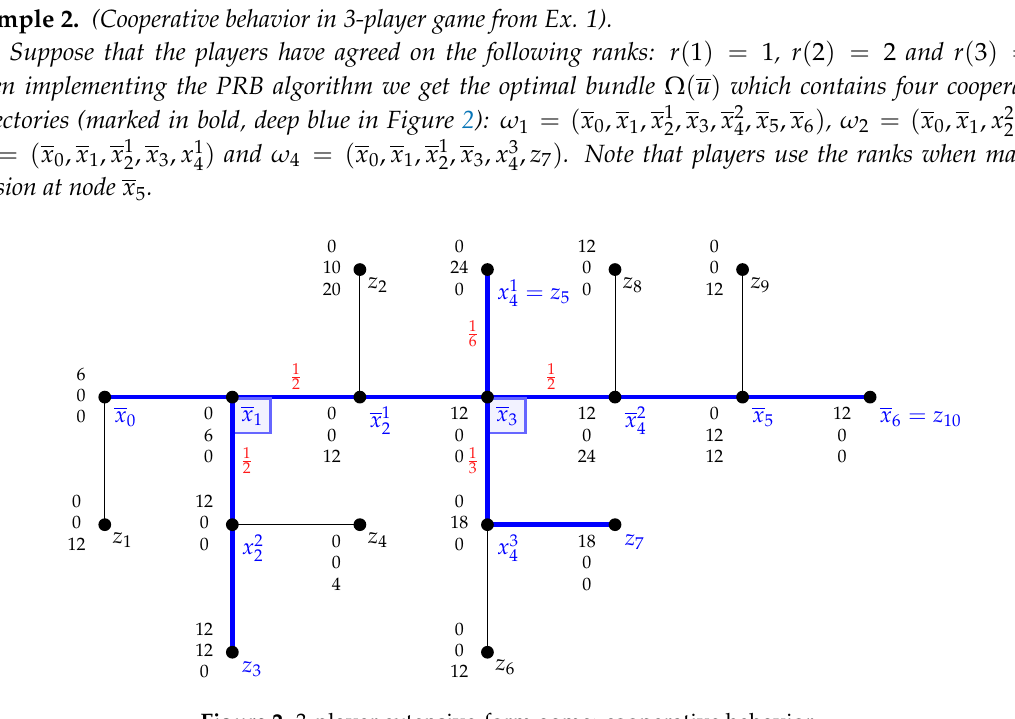
Figure 2. 3-player extensive-form game: cooperative